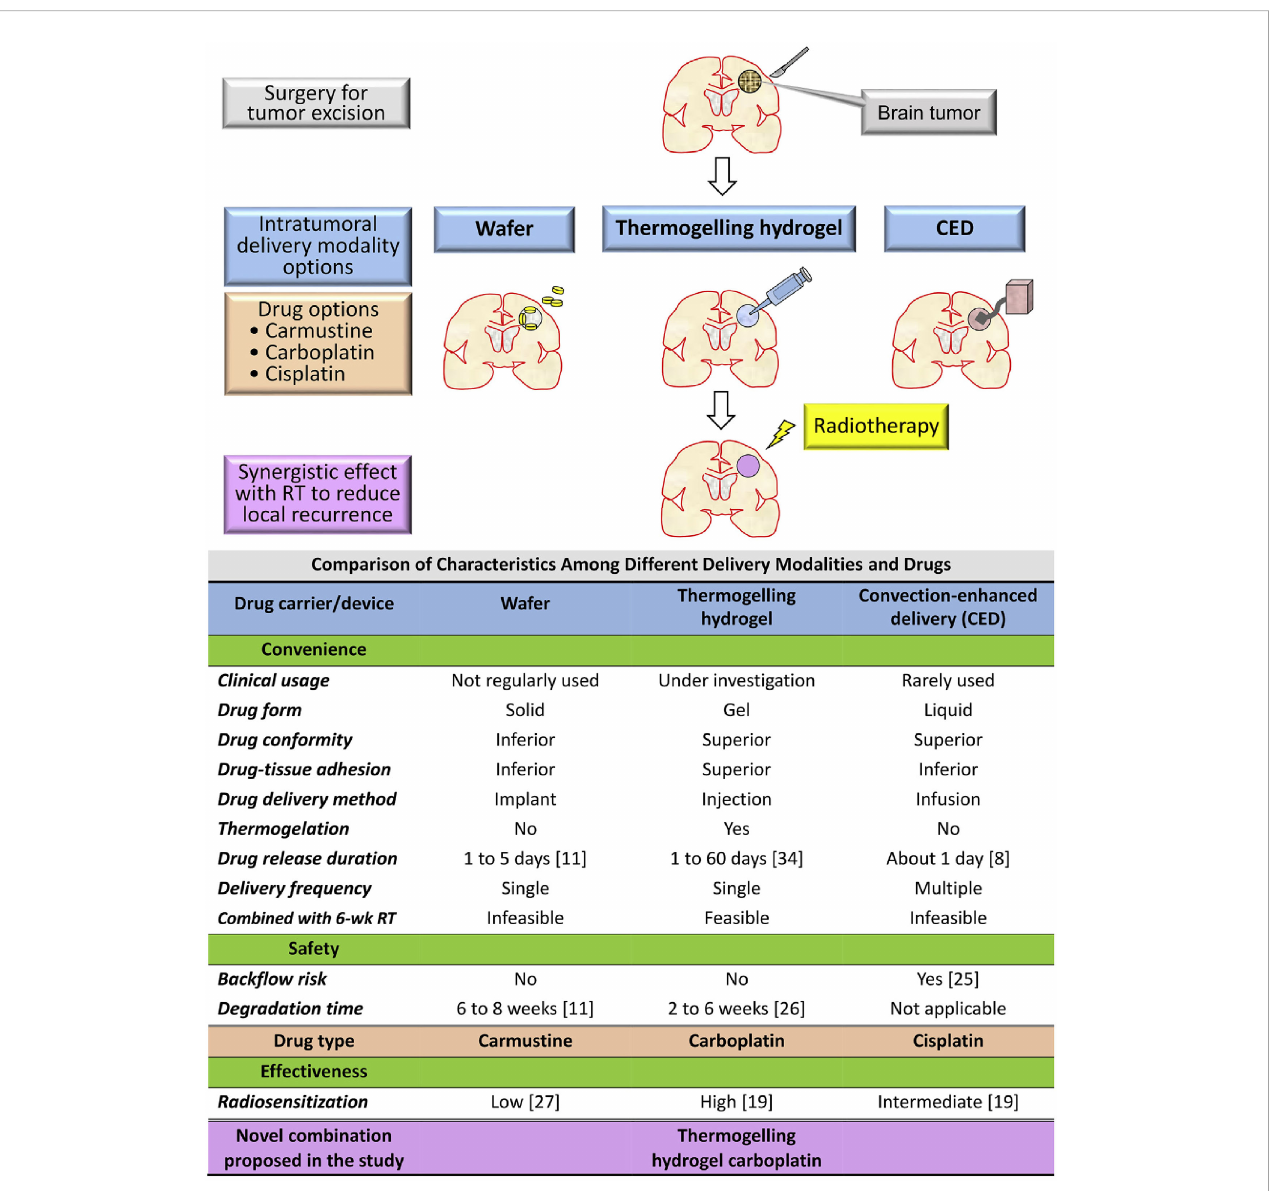
FIGURE 4 Rationale and purpose of this study: To compare the characteristics of intratumoral delivery modalities and drugs for malignant gliomas and propose a novel combination to satisfy the unmet clinical need of convenience, effectiveness, and safety. RT, radiotherapy; wk, week